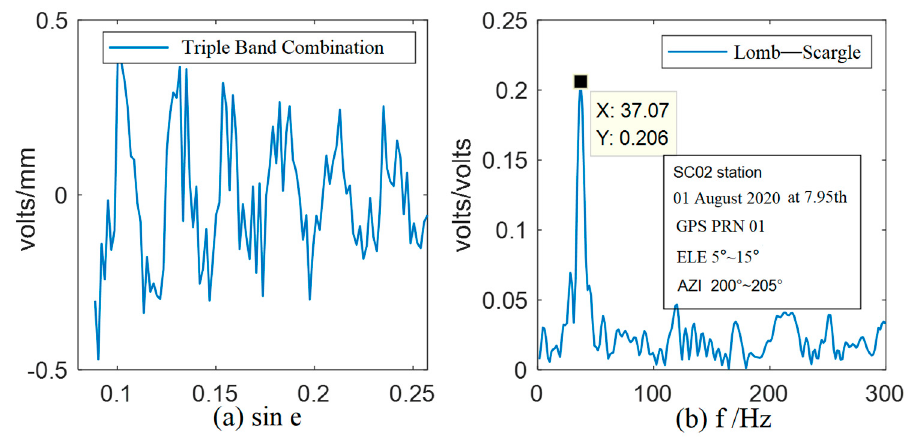
6 of 11 Figure 3. The geographical location of the sc02 station. 3.1. Model Establishment By observing the satellite carrier-phase data and the sea-surface height change for a period of time, a primary model between the triple-frequency combined-phase observation value for tide level monitoring and the effective inversion height is established. Figure 4 shows the periodic diagram (Figure 4a) of the observed value of the triple-frequency combined phase in the low-altitude angle area of a typical GPS satellite varying with the satellite altitude angle and the corresponding Lomb–Scargle spectrum